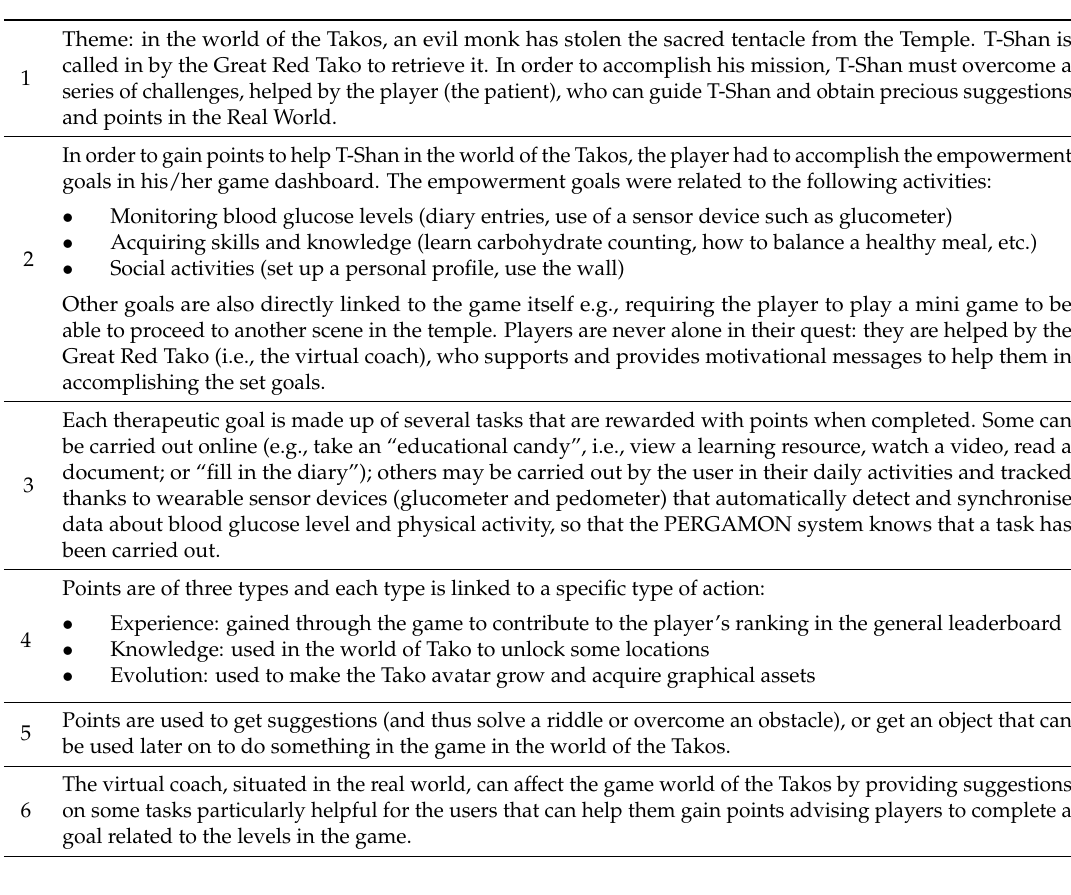
Table 1. Main characteristics and game elements of the Tako Game for diabetic children (see Figure